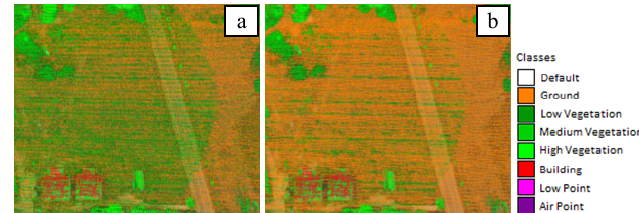
Figure 2. The results of the vegetation class parameter analyses before (a) and after (b).